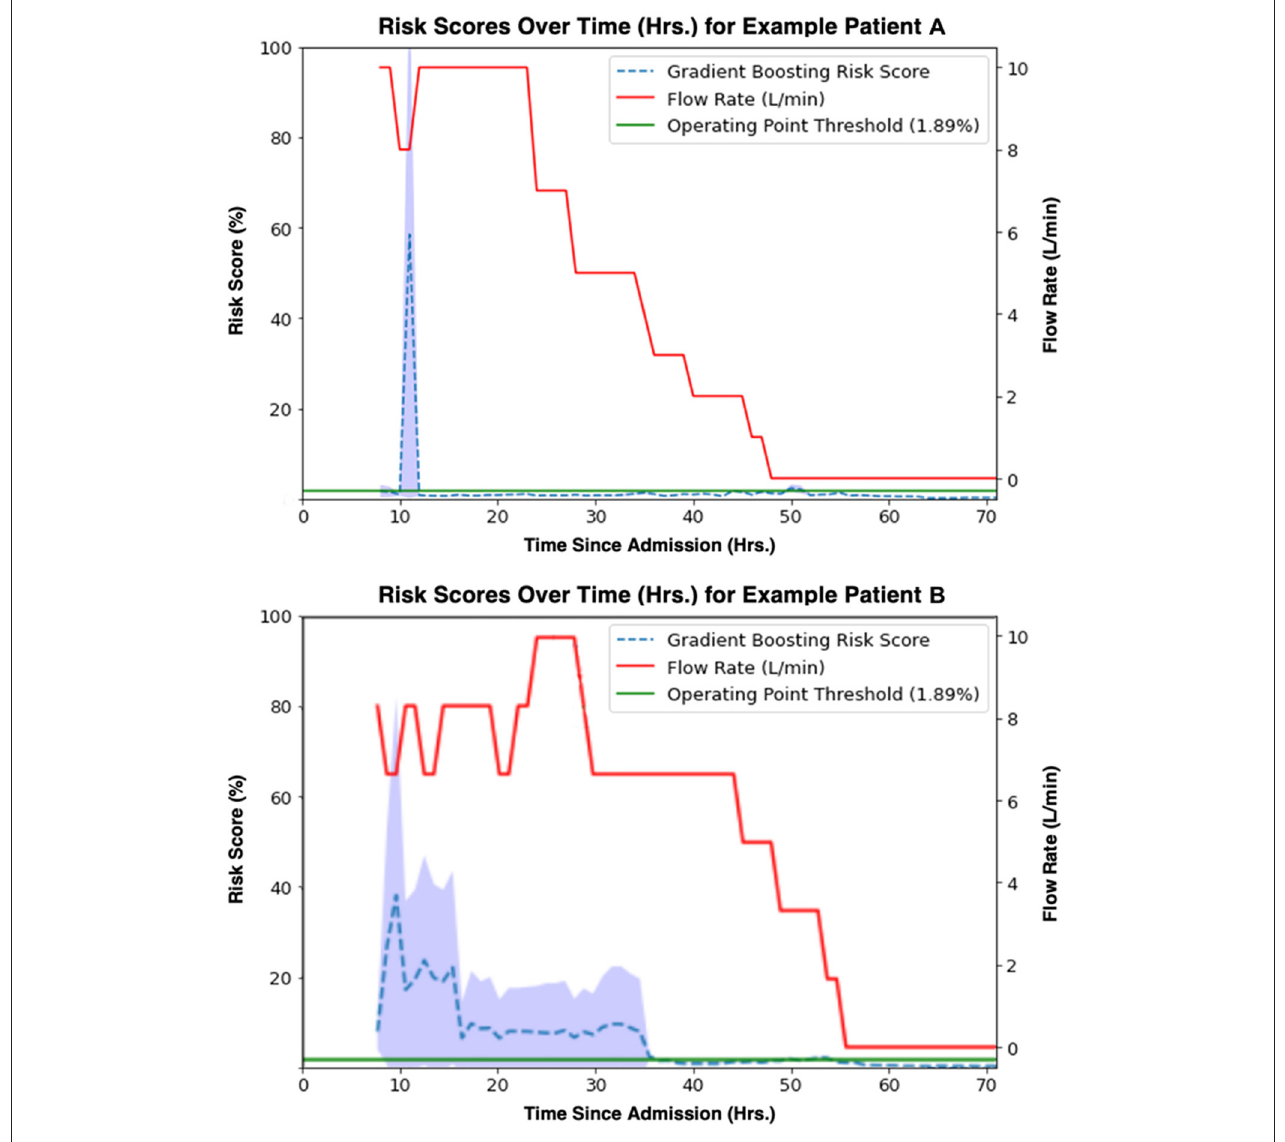
FIGURE 8 | Gradient boosting model (time window = 8h, lead time = 1h) risk scores [%] (blue) aligned with true flow rate [L/min] (red) for two example patients’ observation periods. A threshold (1.89%) at the model operating point is shown in green.